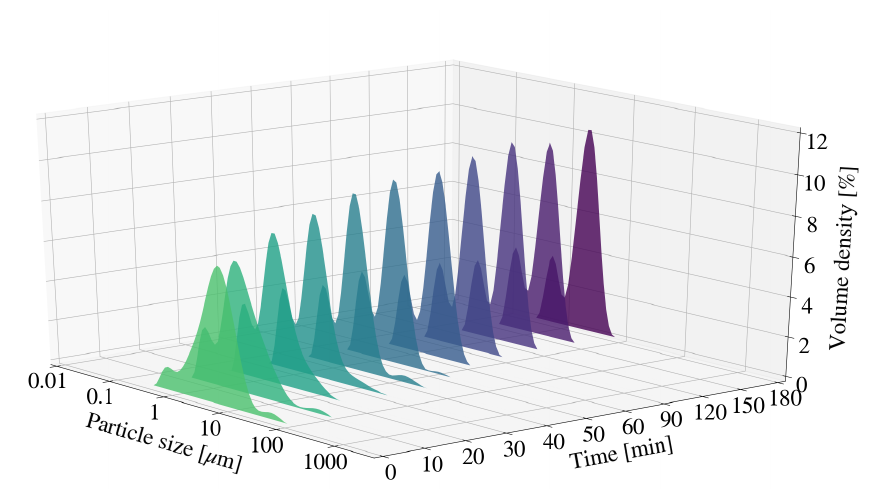
Figure 4. Particle size distribution for Mg-Al LDH samples synthesised at a cooling water inlet temperature of 30 °C, with a change in residence time